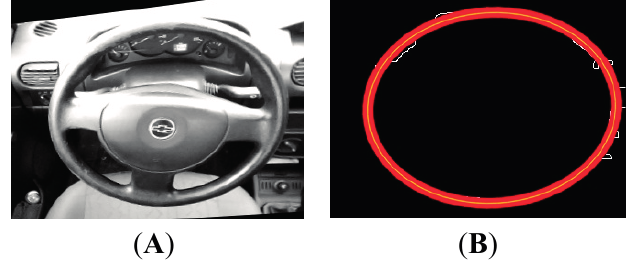
Figure 16. Ellipse segmentation final ( A ) Original ( B ) Contour ( C ) Ellipse ( D ) Image